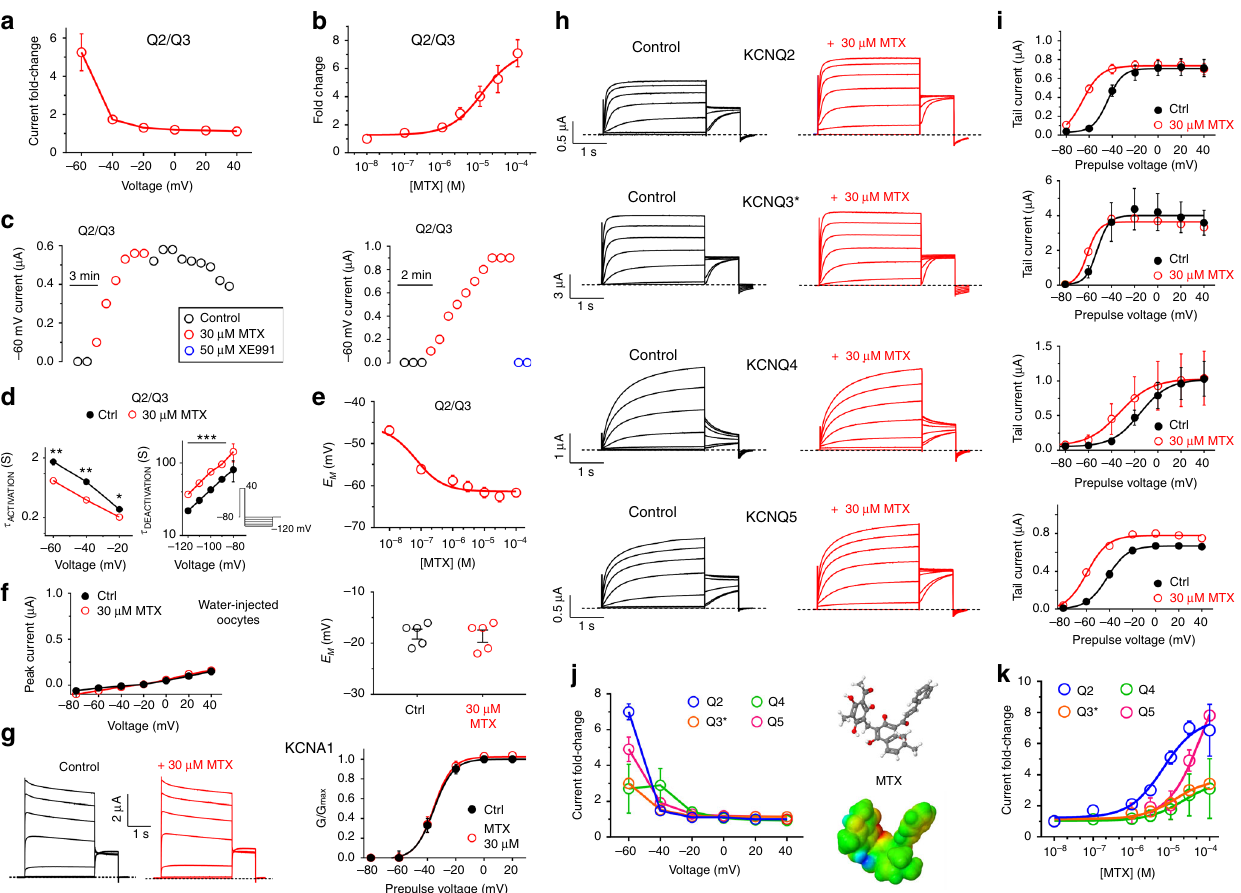
Fig. 2 MTX preferentially activates KCNQ2. a Voltage dependence of KCNQ2/3 current fold-increase by MTX (30 µ M), plotted from traces as in Fig. 1 ( n = 9). b Dose response of KCNQ2/3 channels at − 60 mV for MTX (calculated EC = 11.5 µ M; n = 4 – 9). c Exemplar − 60 mV KCNQ2/3 current ( left ) 50 during wash-in/washout of MTX; right , during wash-in of MTX followed by XE991. d Mean activation ( left ) and deactivation ( right ) rates for KCNQ2/3 before (Ctrl) and after wash-in of MTX ( n = 9); *** p < 0.001. Activation rate was quanti fi ed using voltage protocol as in Fig. 1d. Deactivation rate was quanti fi ed using voltage protocol shown ( lower right inset ). e MTX dose-dependently hyperpolarizes resting membrane potential ( E M ) of unclamped oocytes expressing KCNQ2/3; n = 9. f MTX has no effect on ( left ) endogenous mean current or (right) E M of water-injected control oocytes ( n = 5). Voltage protocol as in Fig. 1d. g MTX has no effect on ( left ) averaged current traces or ( right ) G / G max of oocytes expressing KCNA1 ( n = 5). Voltage protocol as in Fig. 1d. h Averaged current traces for homomeric KCNQ2 – 5 channels in the absence ( Control ) or presence of MTX (30 µ M) ( n = 5 – 10). Voltage protocol as in Fig. 1d. i Mean effects of MTX (30 µ M) on − 30 mV tail currents for channels and voltage protocol as in h ( n = 5 – 10). j . Mean voltage dependence of 30 µ M MTX (structure and surface potential, right ) activation of homomeric KCNQ2 – 5 at − 60 mV, recorded from tail currents as in i ( n = 5 – 10). k MTX dose response at − 60 mV for homomeric KCNQ2 – 5, quanti fi ed from data as in i ( n = 5 – 10). All error bars indicate